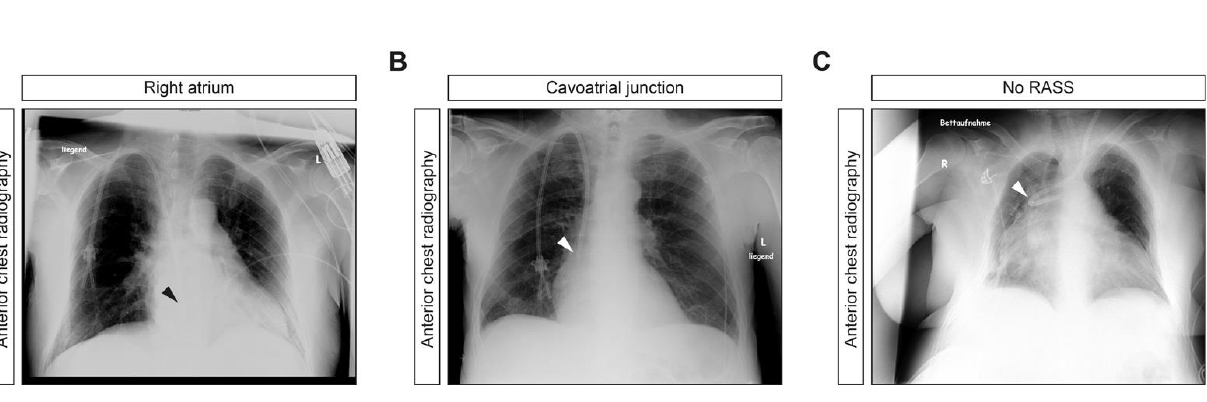
Figure 3. Portable anterior-posterior chest radiography. ( A , B ) Representative radiographic images of proper HDC placement, with tip position in the right atrium or cavoatrial junction (arrowheads). ( C ) Radiographic image of improper HDC placement, with kinking at the subclavian-caval junction, due to central vein stenosis (arrowhead). Abbreviations: HDC, hemodialysis catheter; RASS, rapid atrial swirl sign.